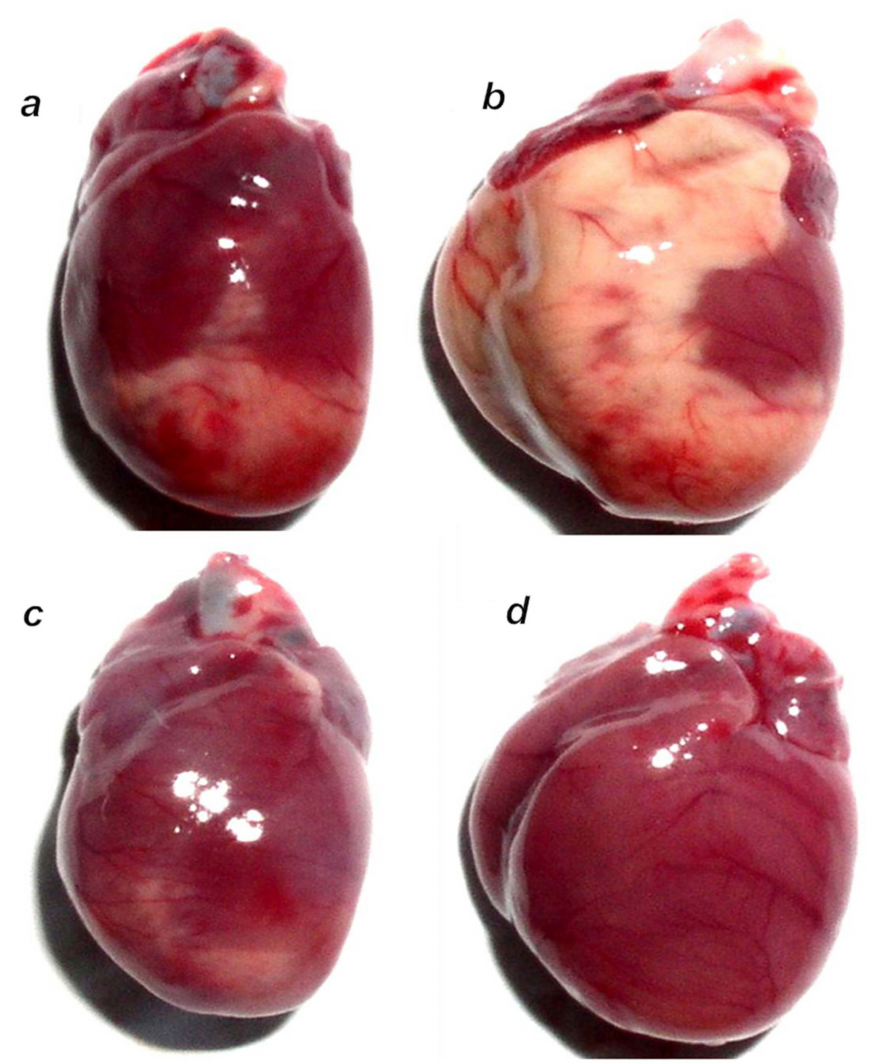
Figure 14. Illustrative gross presentation of anterior heart surface in rats at 24 h after isoprenaline. Rats challenged once with isoprenaline 150 mg/kg s.c., mediation at 30 min before